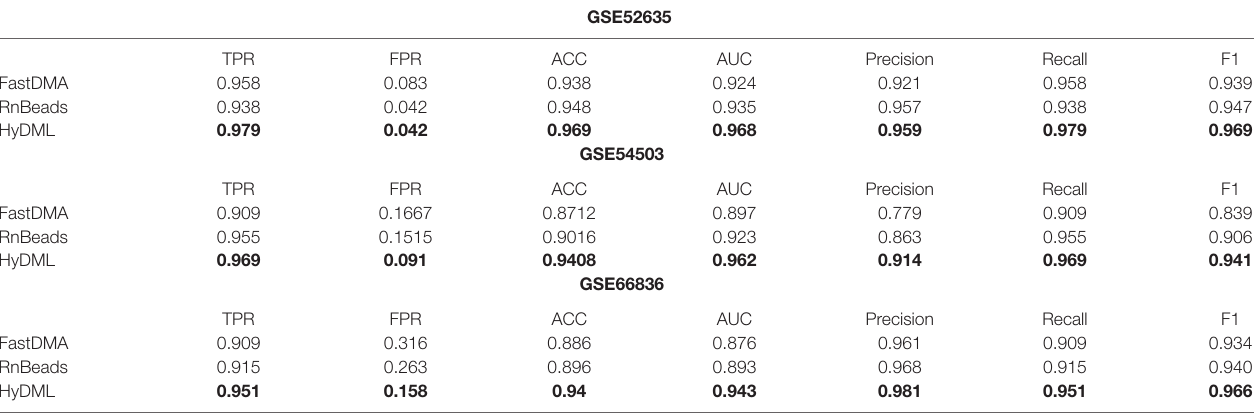
TABLE 1 | Classification performance comparison on three independent test